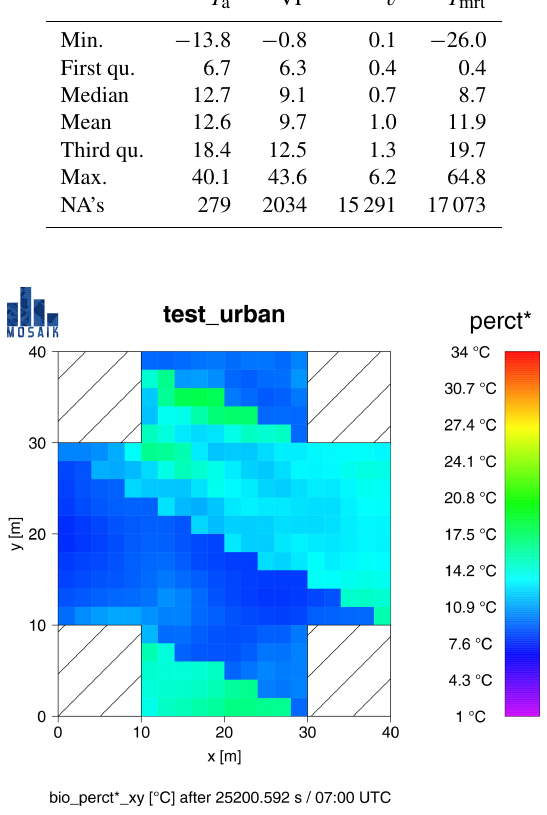
Figure 4. PT (perct ∗ in PALM) for the test case “test_urban” at 07:00UTC (shortly after sunrise) on 6 March. Incident wind is from 270 ◦ with 1.0ms − 1 .